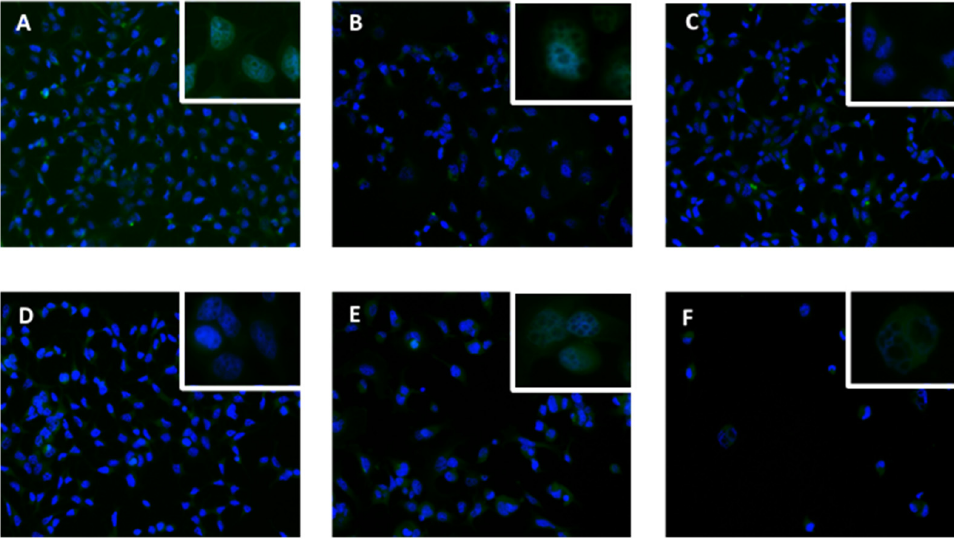
Figure 21. Immunofluorescence analysis of E-cadherin clone 24E10 (green) in MCF-7 cells. ( A ) MCF-7 with no treatment; ( B ) Cells treated with the reference drug, paclitaxel; ( C ) Cells treated with benztropine; ( D ) Cells treated with thioridazine; ( E ) Cells treated with the combination of the IC50 of paclitaxel and benztropine; ( F ) Cells treated with the combination of the IC50 of paclitaxel and thioridazine. The images were taken at a 20 × magnification. On the right top corner of each image is an insert at 40 × magnification (20 × 30 ms DAPI/ 2 s FITC; 40 × 4 ms DAPI/ 1 s